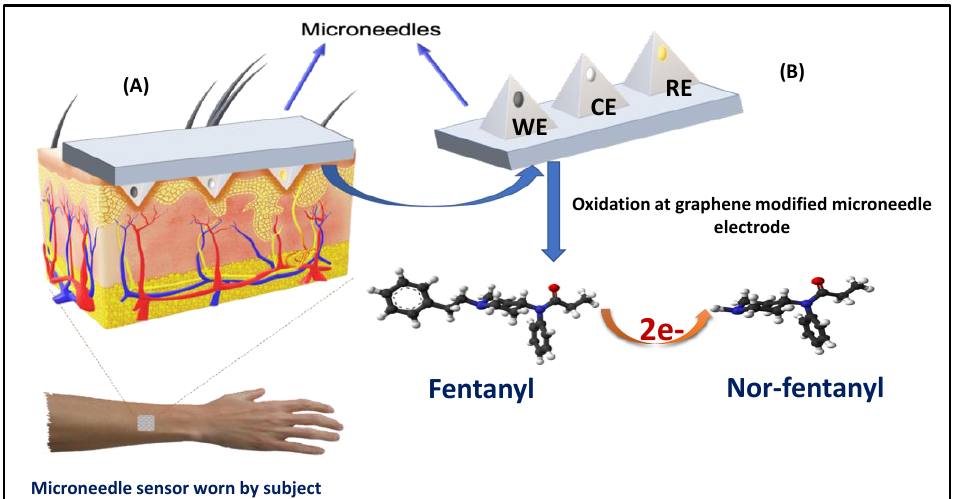
Figure 1. Schematic illustration of fentanyl detection on graphene-modified microneedle working sensor and sensor detection mechanism for future on-body applications. ( A ) Microneedle array placed on the skin for fentanyl sensing and ( B ) fentanyl oxidation at graphene-modified microneedle sensor using SWV.